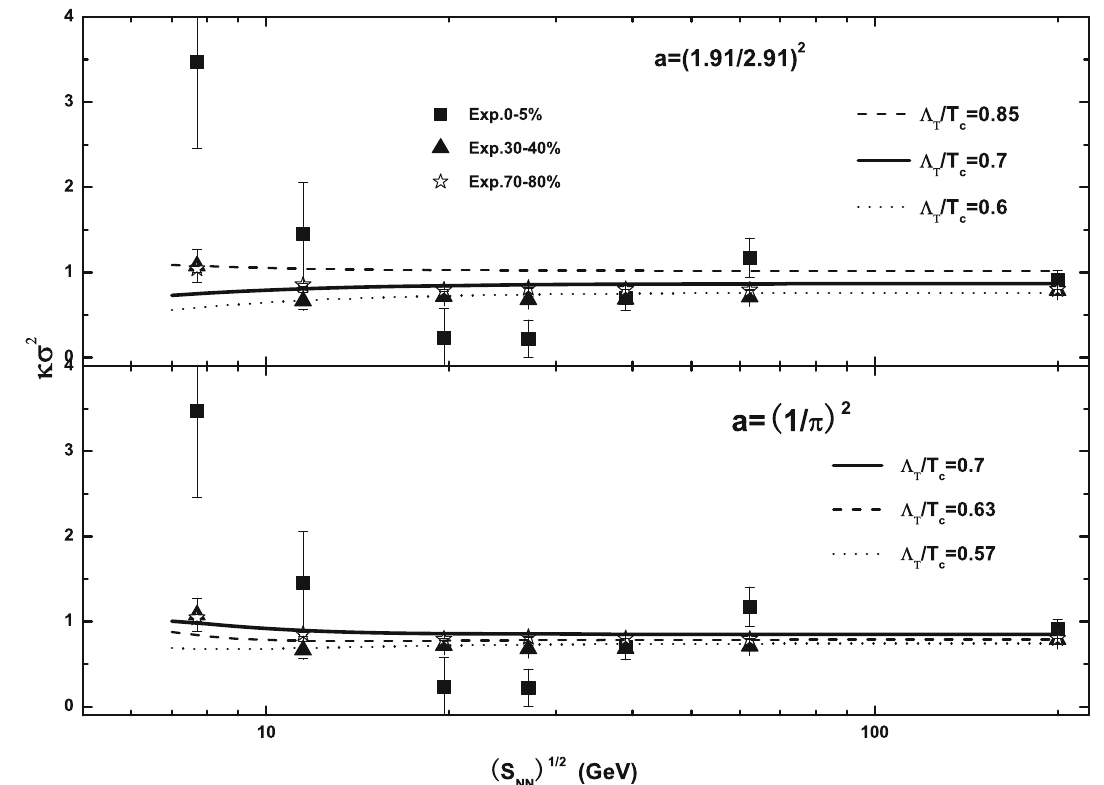
√ S NN for (cid:10) T / T c = 0 . 85 , 0 . 7 , 0 . 6 at a = ( 1 . 91 / 2 . 91 ) 2 . The bottom three